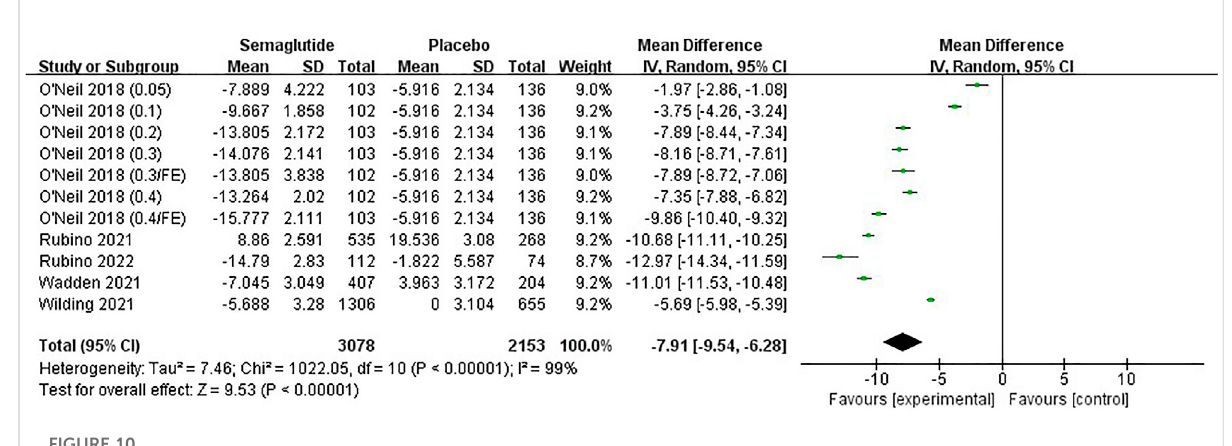
FIGURE 10 | Meta-analysis results of TC change (mg/dl) in included trials.